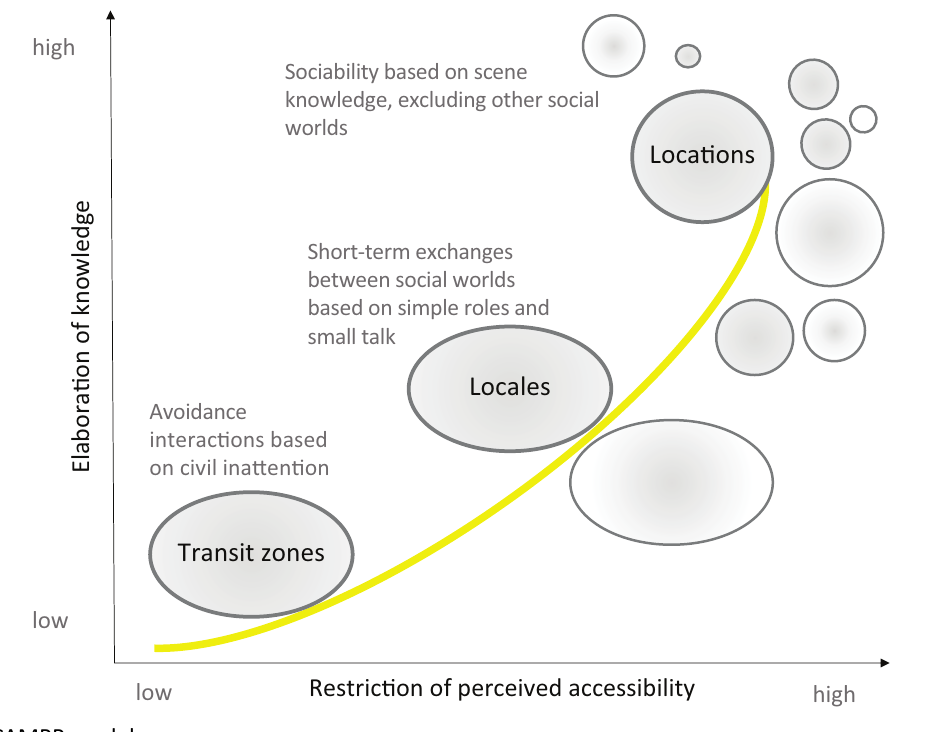
Figure 1. The CAMPP